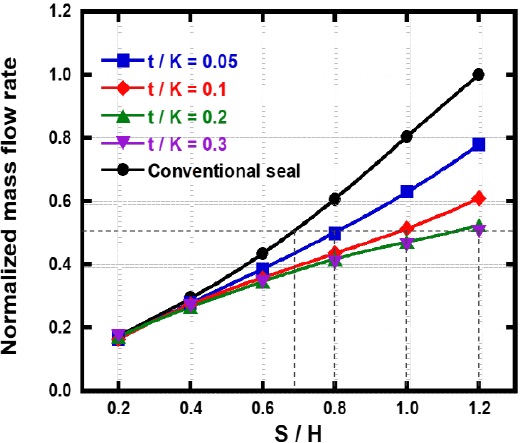
Figure 13. Variation in the leakage mass flow rate with S/H and t/K (PR = 2.5, β = 90°).